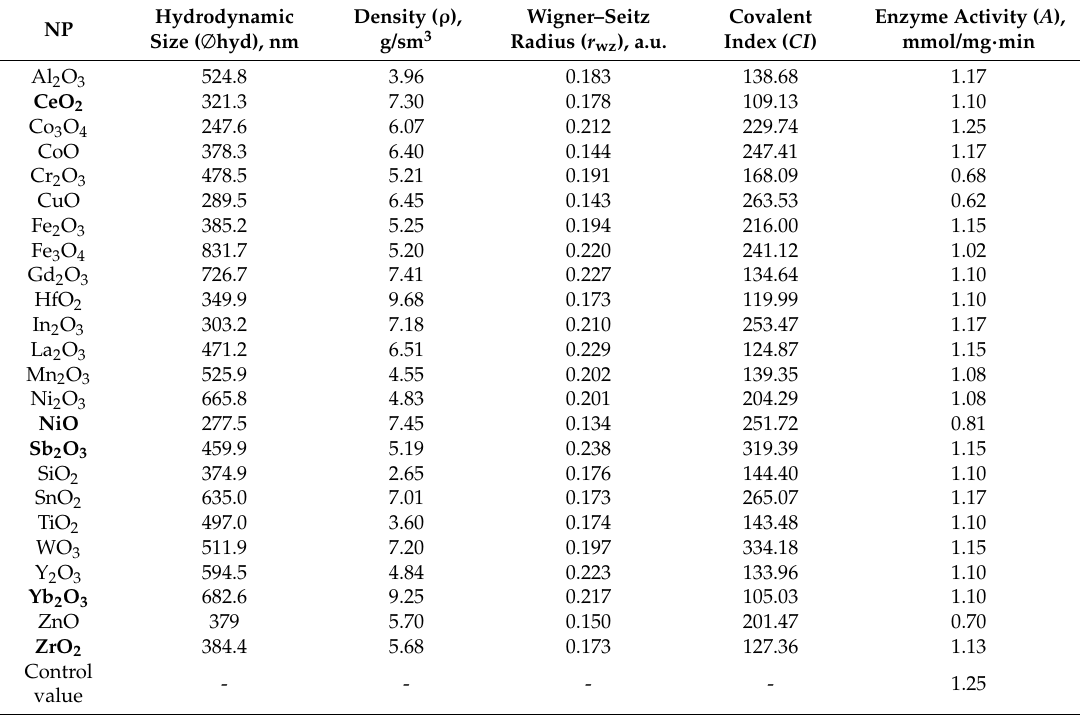
Table 2. Experimental data and theoretical descriptors. NP: